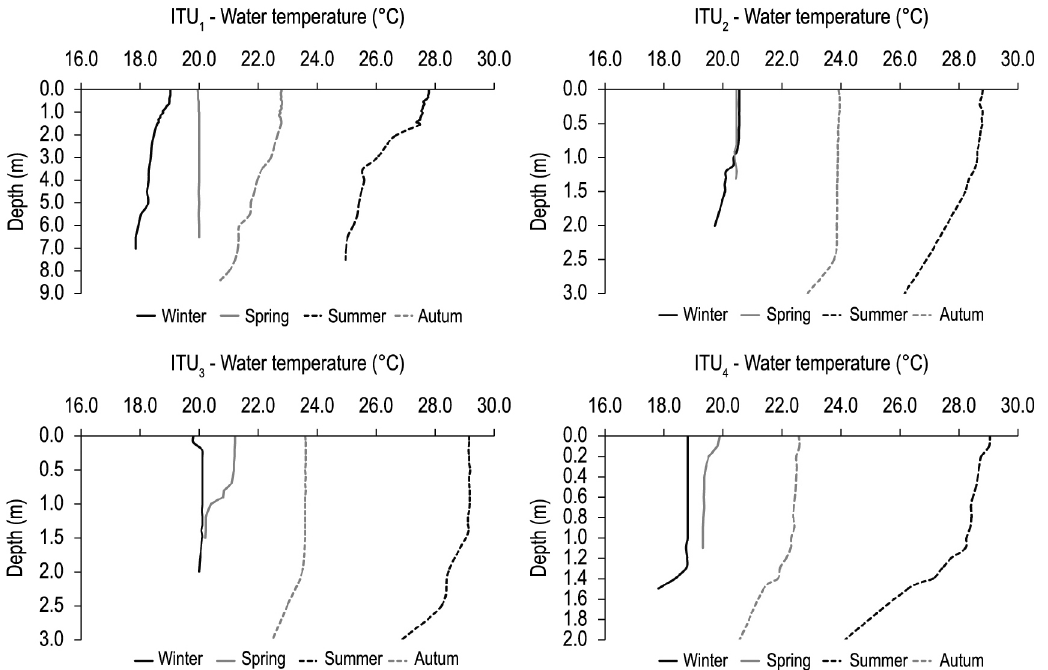
Figure 3. Vertical variation of water temperature (°C) in four arms of Itupararanga Reservoir in different seasons (Winter-August/2009; Spring-October/2009; Summer-February/2010; Autumn-April/2010). substrate fractions did not show seasonal significant